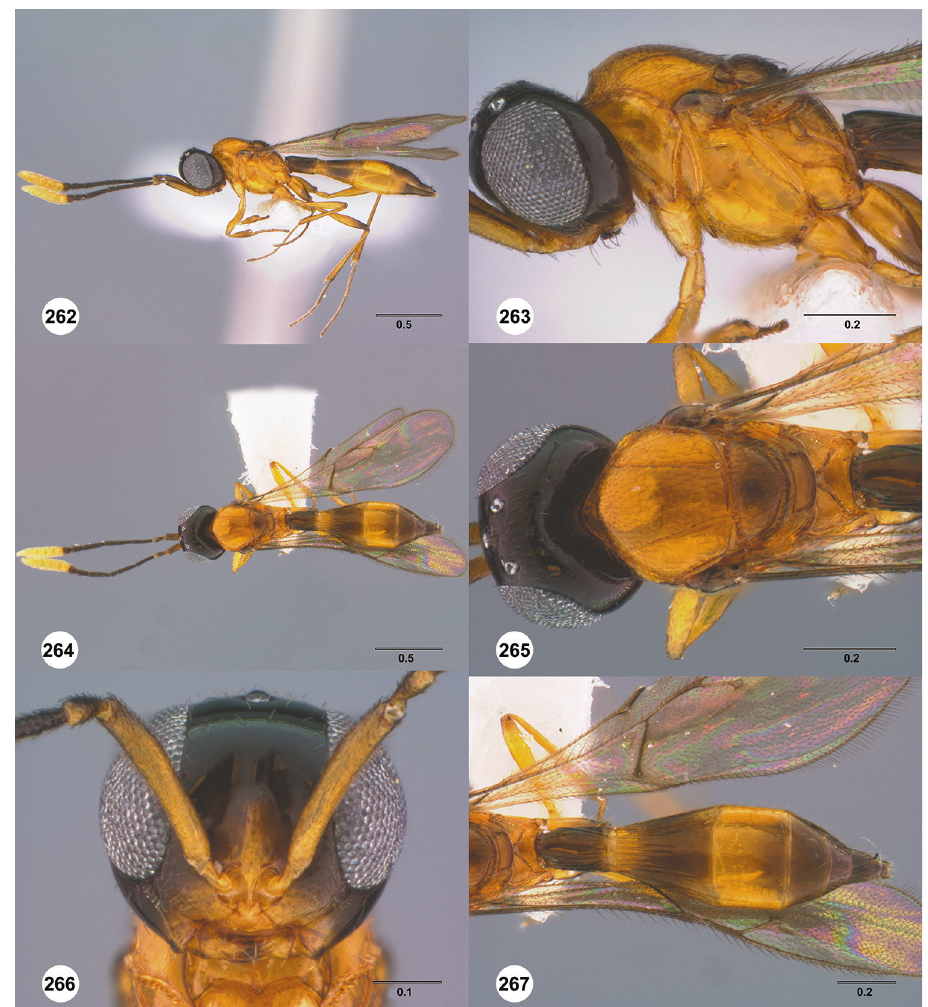
Figures 262–267. Calliscelio torqueo sp. n., female, holotype (OSUC 553598). 262 Lateral habi- tus 263 Head and mesosoma, lateral view 264 Dorsal habitus 265 Head and mesosoma, dorsal view 266 Head, anterior view 267 Metasoma, dorsal view. Scale bars in